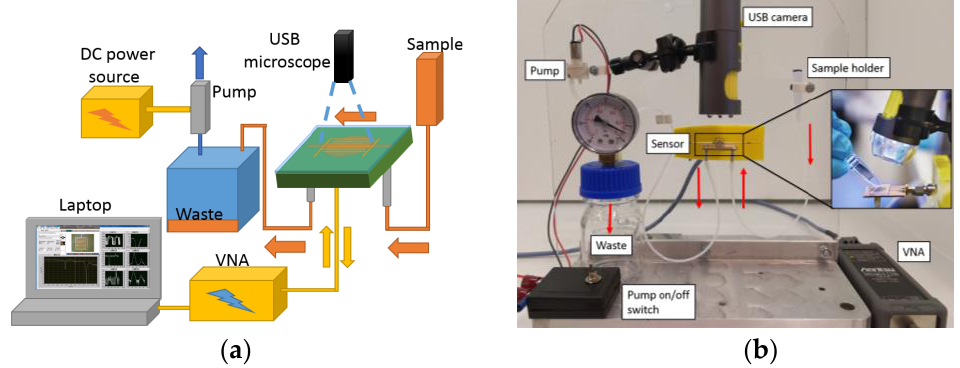
Figure 5. Measurement and sample pumping system: ( a ) schematic presentation ( b ) photograph of the system (the computer and voltage source are not shown).